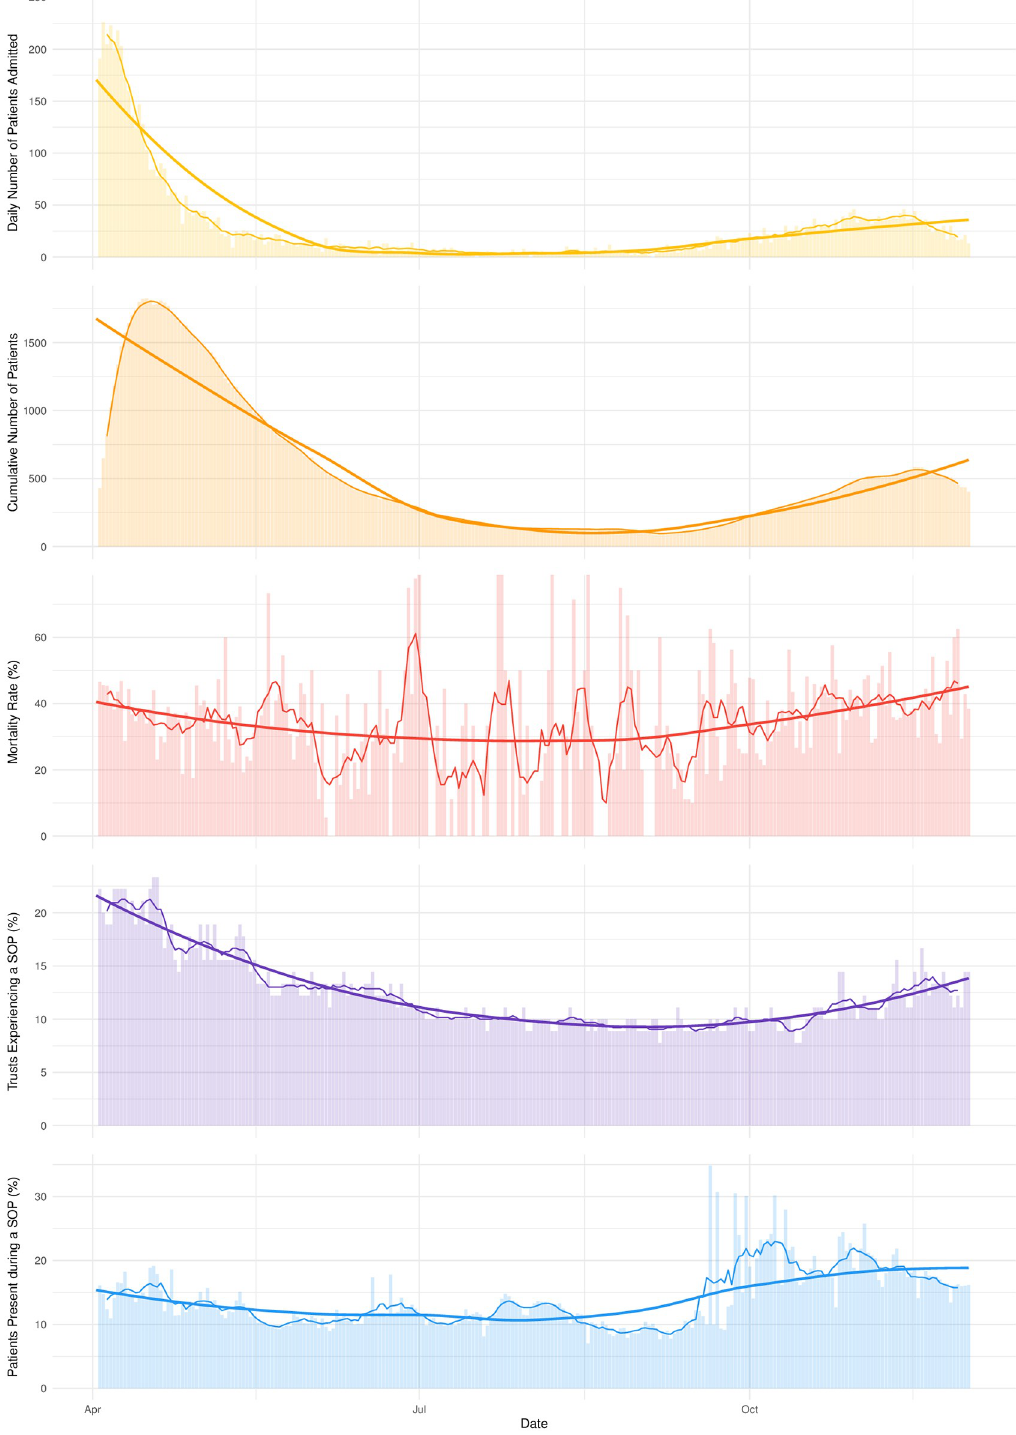
Fig 2. Histograms of: 1) the daily number of admissions recorded in CHESS (Yellow); 2) the cumulative number of patients present on each day (Orange); 3) the mortality rate over the study period (Red); 4) the percentage of trusts experiencing a SOP on each day (Purple); 5) and the percentage of all patients in CHESS that were admitted to trust experiencing a SOP on each day (Blue), respectively from top to bottom. Each histogram is based on the 7-day rolling mean and loess smoothed curves. As such, there is a lagged peak in the cumulative number of patients present on each day (Orange),